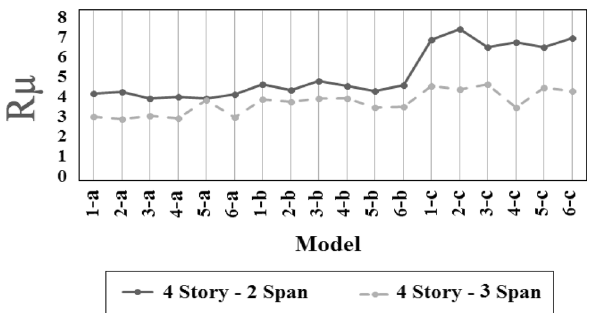
Fig. 13 The ductility coefficient of 4- and 8-story 2-span structure